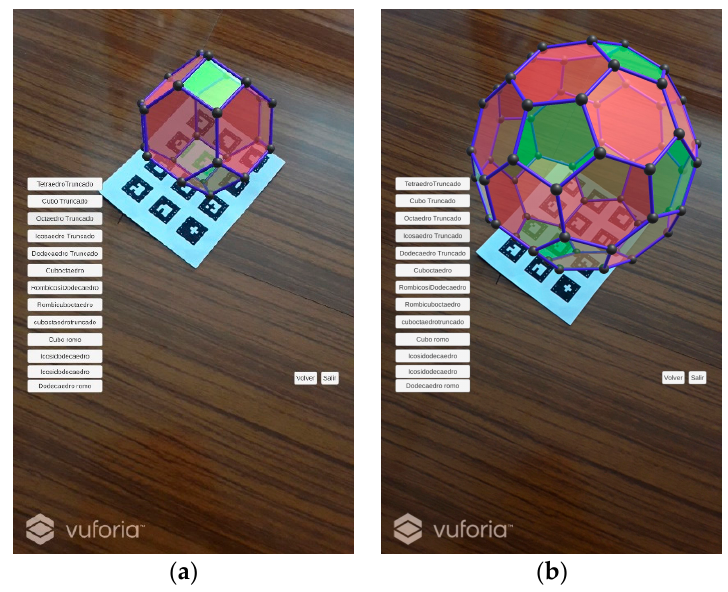
Figure 10. Images of ( a ) truncated octahedron and ( b ) truncated icosahedron with AR.